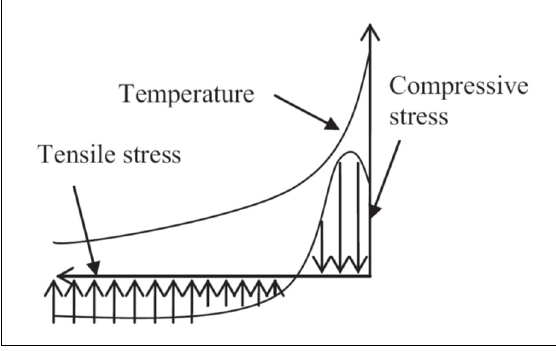
Figure 10. Process of pore pressure explosion spalling of concrete [14].